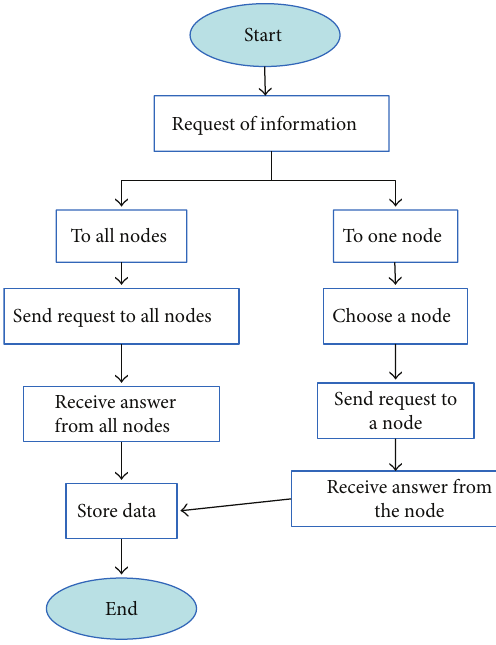
Figure 7: Request of information.